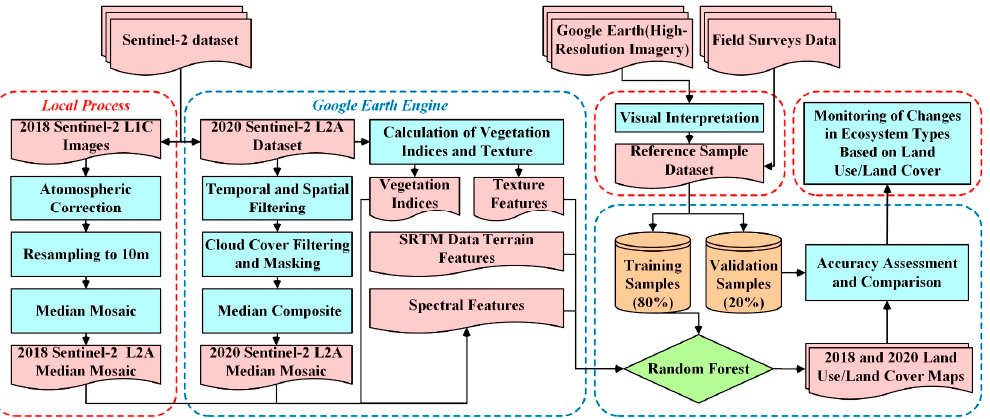
Figure 3. Flow chart of the land use/land cover (LULC) mapping and analysis methodology for this